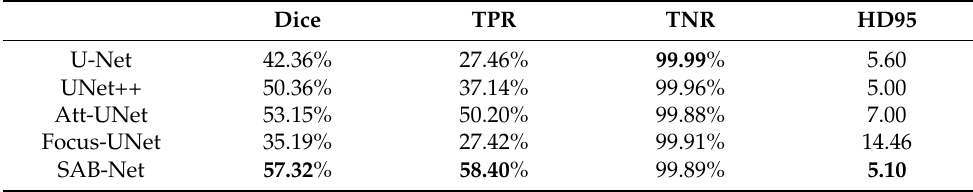
Table 4. Segmentation results obtained on the Heart MRI